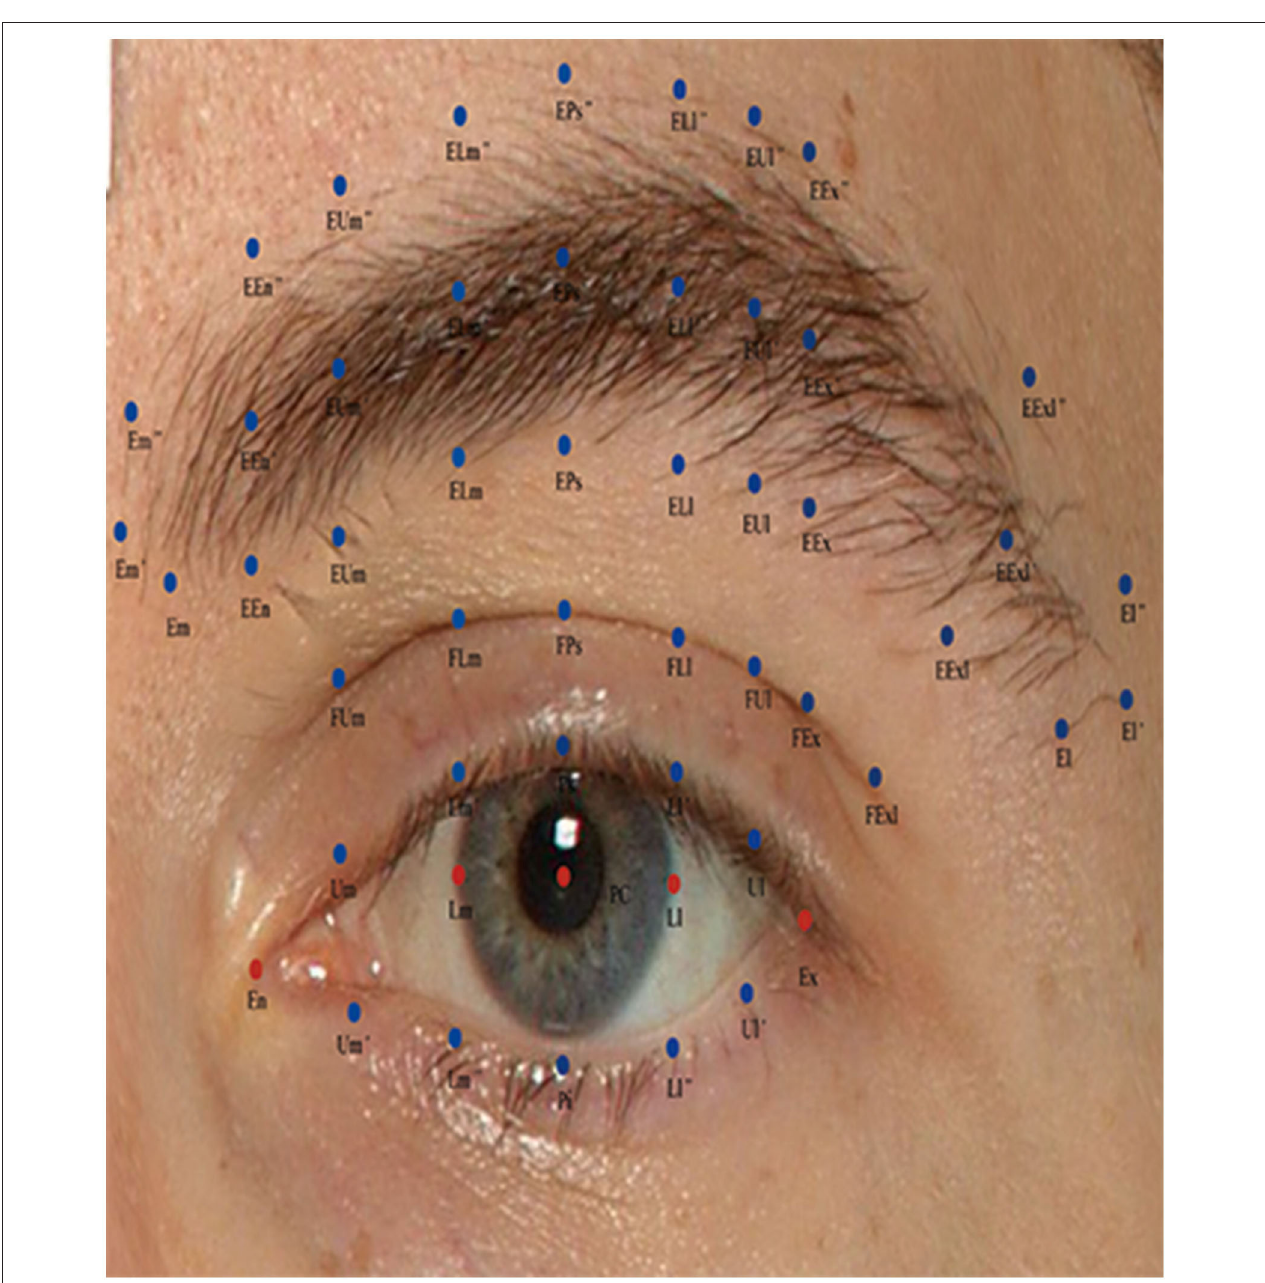
FIGURE 2 | Description of periocular anthropometric landmarks used in this study. Periocular anthropometry was performed according to Guo et al. (17).